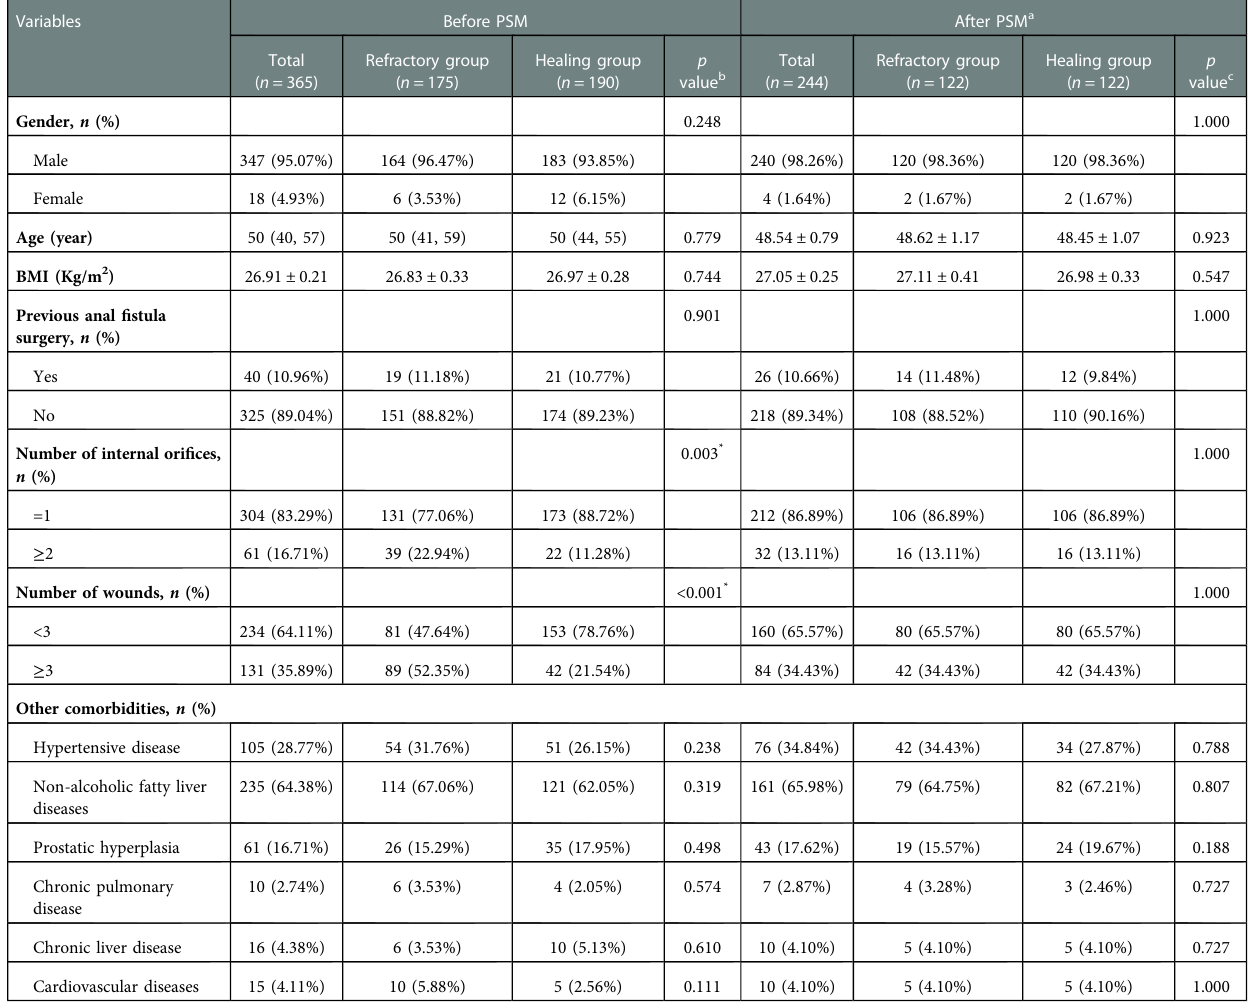
TABLE 1 The clinical characteristics of patients with anal fi stula combined with